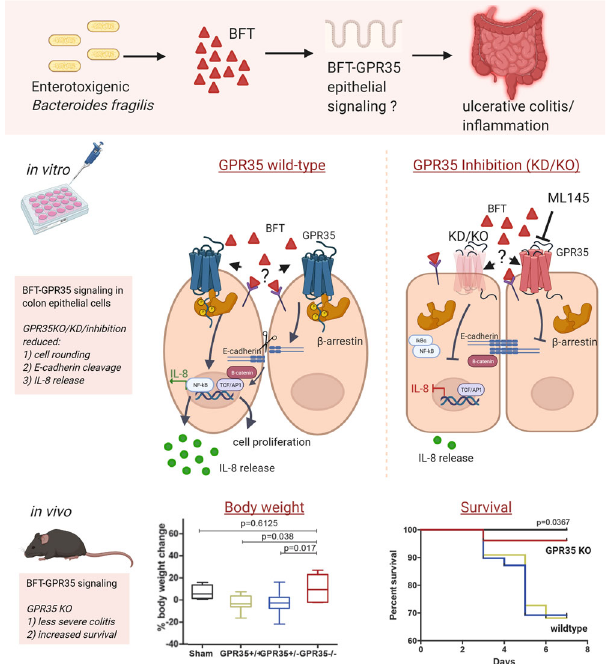
Fig. 7 Graphical abstract. Graphical abstract summarizing the in vitro and in vivo fi ndings on enterotoxigenic Bacteroides fragilis (ETBF) toxin (BFT) and epithelial cell signaling through GPR35. In the top panel, the in vitro fi ndings with GPR35 shRNA knockdown (KD), inhibition with GPR35 antagonist ML145, and CRISPRCas knockout (KO) on morphological change, E-cadherin cleavage, and IL-8 secretion upon stimulation of HT29/ c1 cells with Bactetoides fragilis toxin (BFT). In the bottom panel, the in vivo fi ndings in C57Bl6 wild-type (WT) and GPR35 − / − mice pretreated with cefoxitin antibiotics on body weight change and survival after colonization with ETBF. *Created with